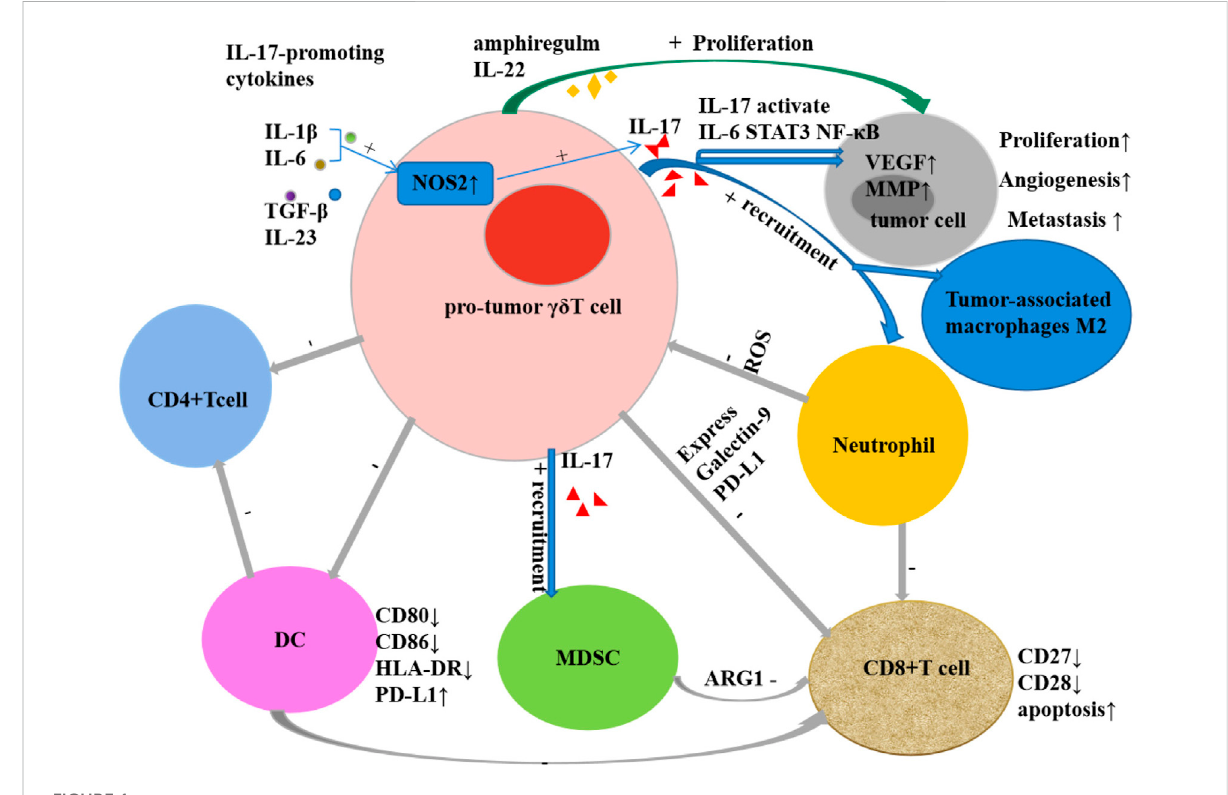
FIGURE 1 The tumor-promoting effect of γδ T